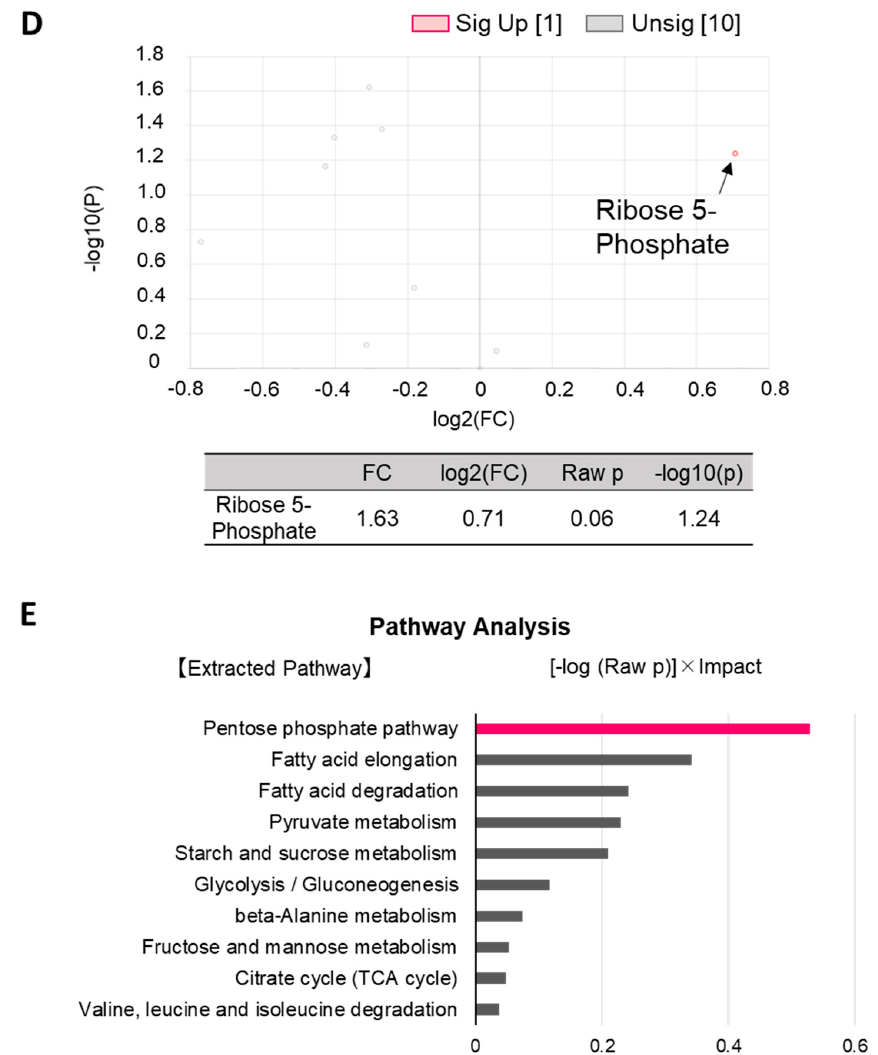
Figure 2. Evaluation of glucose-related metabolism in astrocytes incorporating cGAMP using 13 C6-glucose. ( A ) Predicted distribution of 13 C taken up as 13 C6-glucose. For 13 C-labeled compounds, a representation is shown of the labeled compounds that are theoretically estimated to be the most abundant when the metabolic cycle makes one turn. ( B ) The amount of each metabolite involved in the glycolytic system in cGAMP-incorporated astrocytes or their supernatant after 60 min of 13 C6-glucose addition (n = 3). ( C ) Glucose uptake capacity was evaluated by the amount of 2DG6P in astrocytes after 60 min of 2-deoxyglucose (2-DG) addition. (n = 3, ** p < 0.01, Student’s t -test). Volcano plots ( D ) and pathway analysis ( E ) were analyzed by normalizing the concentration information of the most abundant 13 C-labeled isotope of each metabolite measured in B. The concentration data are presented in Table S2. R5P is the only compound with a significant increase of more than 1.5-fold vs. the empty group ( p < 0.1, performed by MetaboAnalyst 5.0 (http://www.metaboanalyst.ca (accessed on 2 August 2021))). The top 10 pathways in decreasing order of “[-log (Raw p)] × Impact” are shown in Table S3.